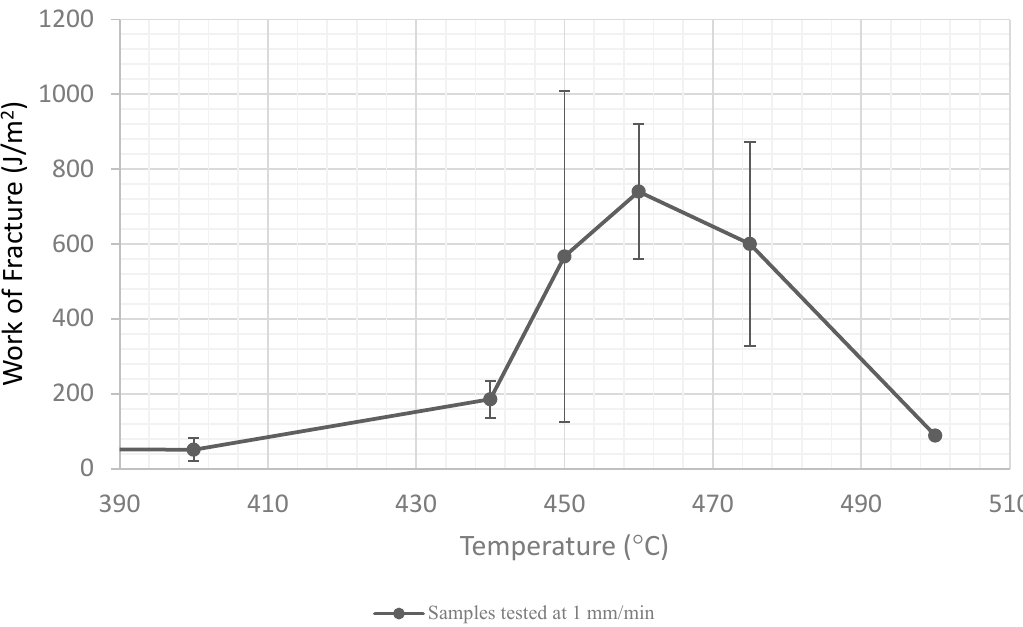
Figure 14. Work of fracture versus testing temperature.